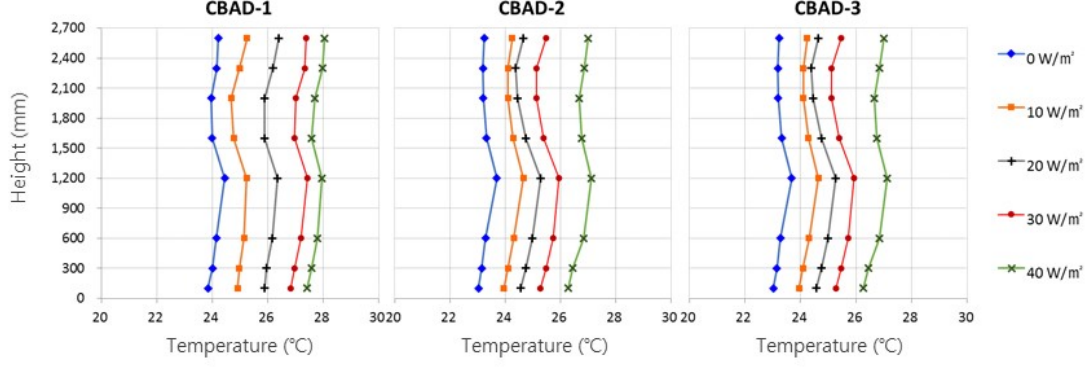
Figure 13. Vertical temperature distribution at (X1, Y2), CBAD.